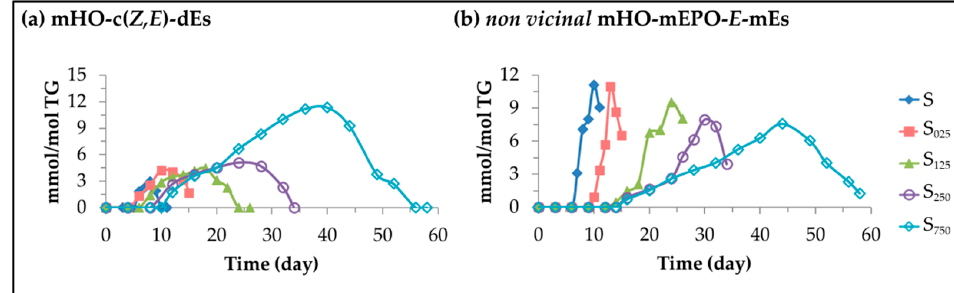
Figure 8. Evolution of the concentration, expressed in mmol/mol TG, in samples S, S 025 , S 125 , S 250 and S 750 over the storage time at 70 °C up to a very advanced stage of their oxidation stage of: ( a ) mHO- and S 750 over the storage time at 70 ◦ C up to a very advanced stage of their oxidation stage c( Z,E )-dEs; and ( b ) non vicinal mHO-mEPO- E -mEs.